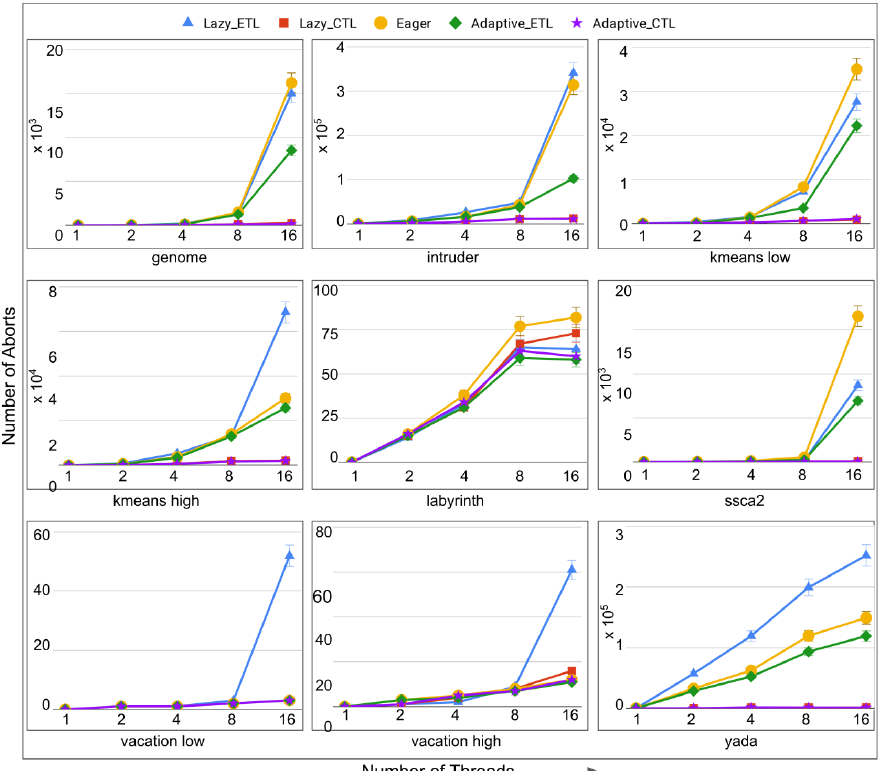
Figure 12. Total number of aborts in STAMP benchmarks in persistent